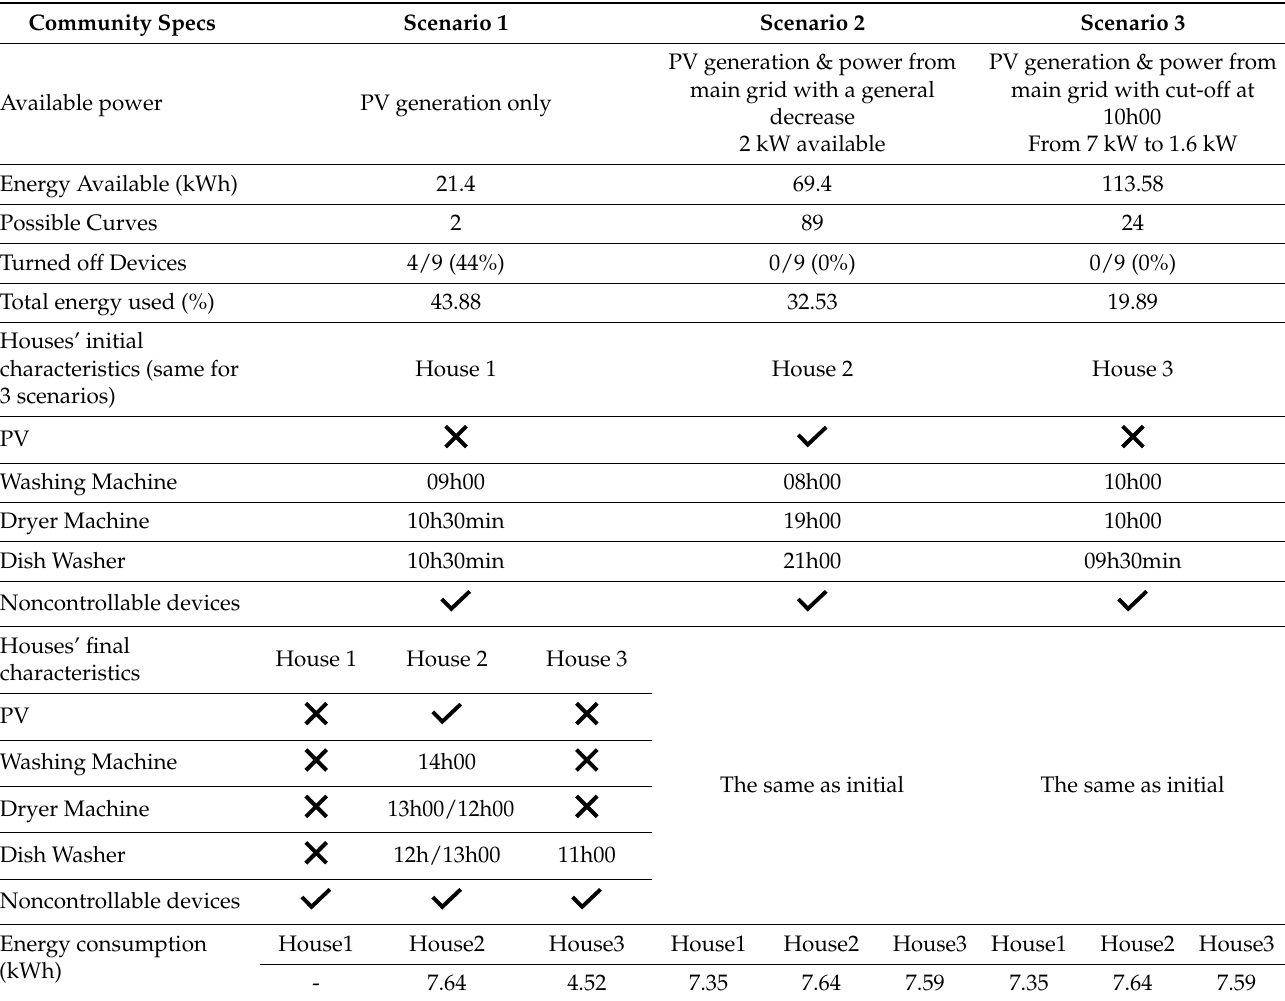
Table 6. Scenario summary.